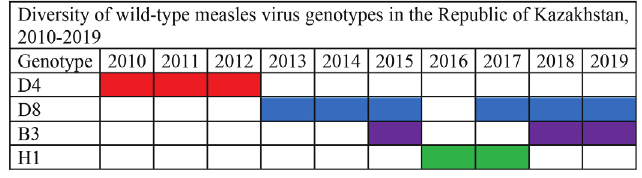
Figure 2 - Diversity of wild-type measles virus genotypes in the Republic of Kazakhstan, 2010-2019